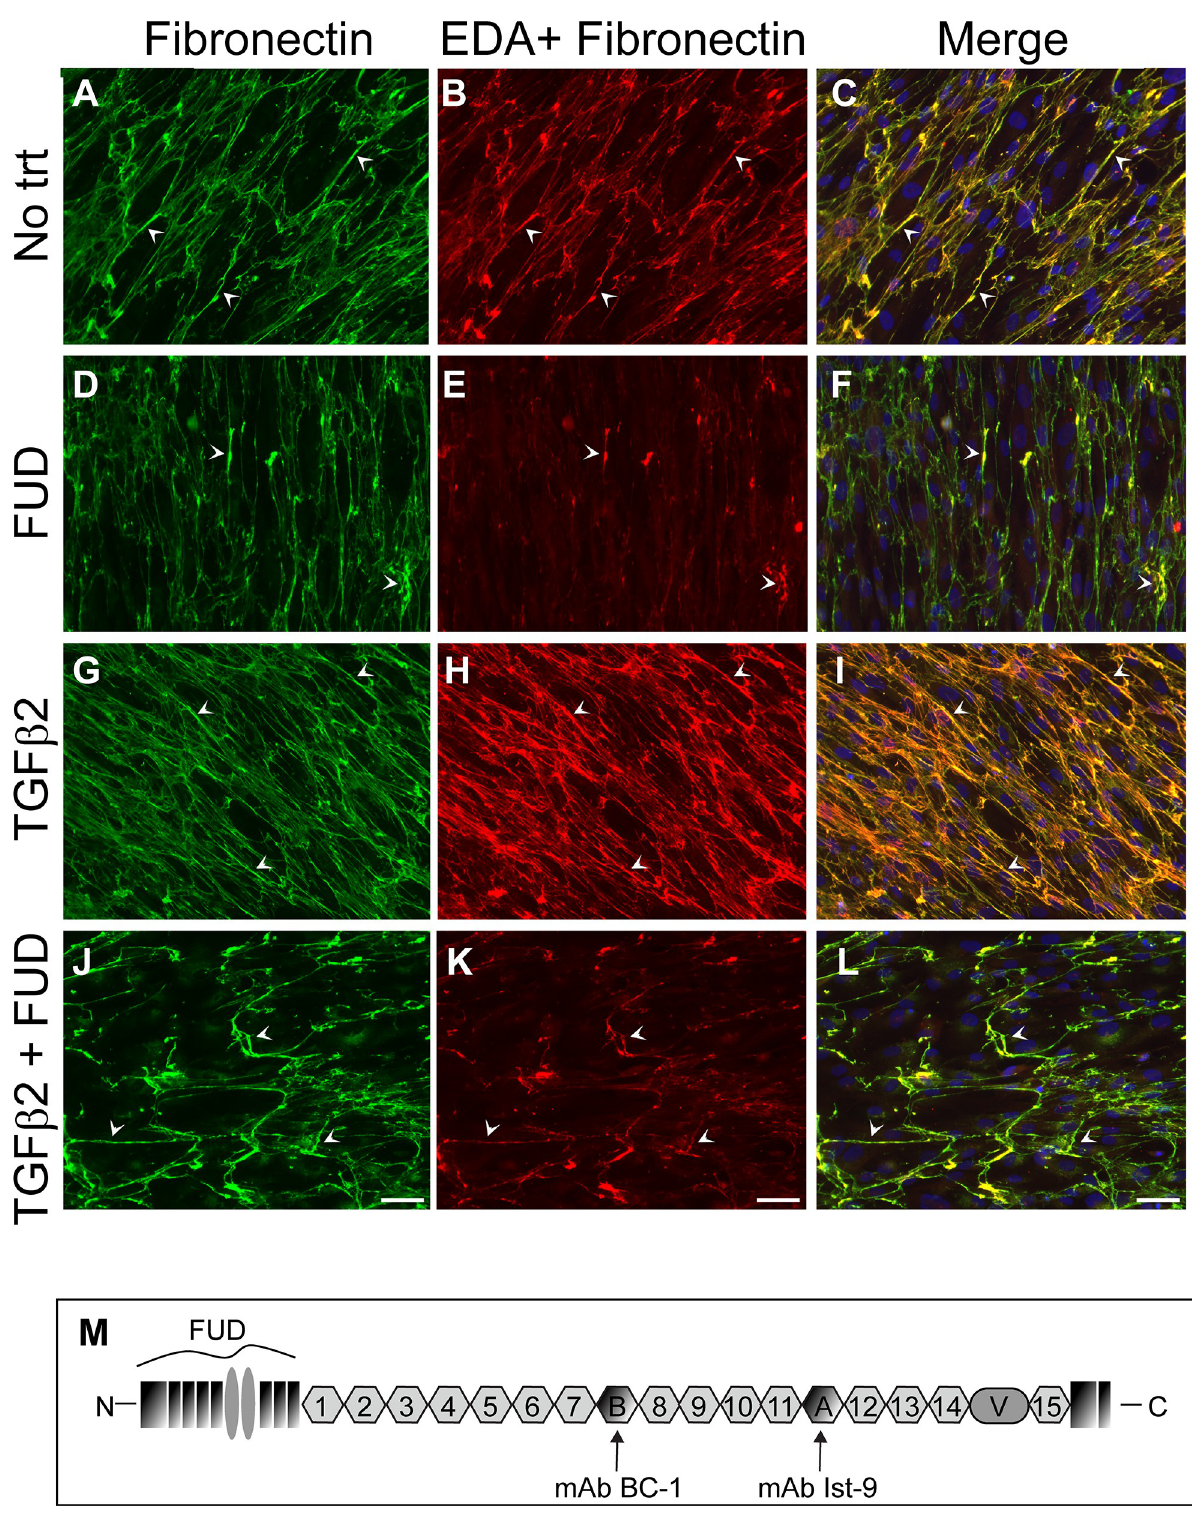
Fig 6. Recombinant FUD prevented TGF β 2 induced increase in fibronectin and EDA+ fibronectin fibrillogenesis. Confluent HTM cultures (N25TM-8) were untreated (A-C) or treated with 2 μ M FUD (D-F), 2ng/ml TGF β 2 (G-I) or both FUD and TGF β 2 (J-L) for 4 days. Cells were then fixed and double labeled with a polyclonal fibronectin sera (A, D, G and J) or an antibody (Ist-9) that recognizes the EDA domain of fibronectin (B, E,